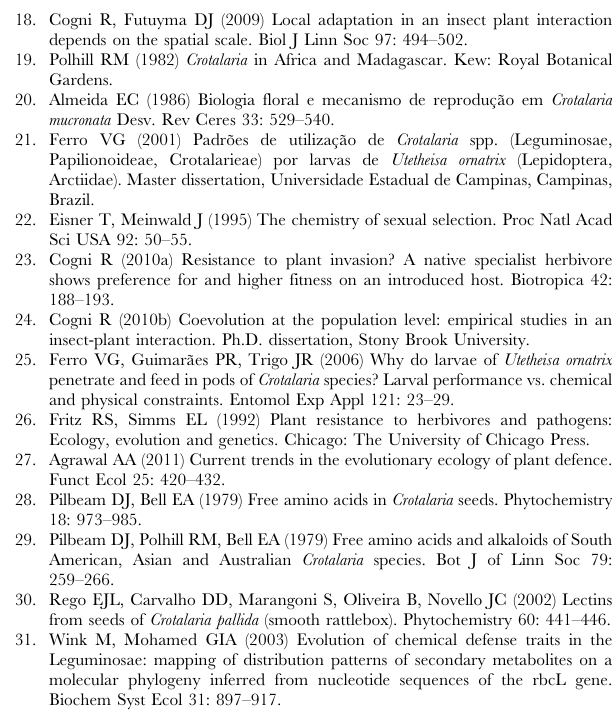
Table S1 Microsatellite loci used in the Utetheisa ornatrix population structure study. Table S2 Test of linkage disequilibrium for pairs of microsat- ellite loci tested across all populations of Utetheisa ornatrix . Table S3 Genetic diversity for each Utetheisa ornatrix microsat- ellite locus on each